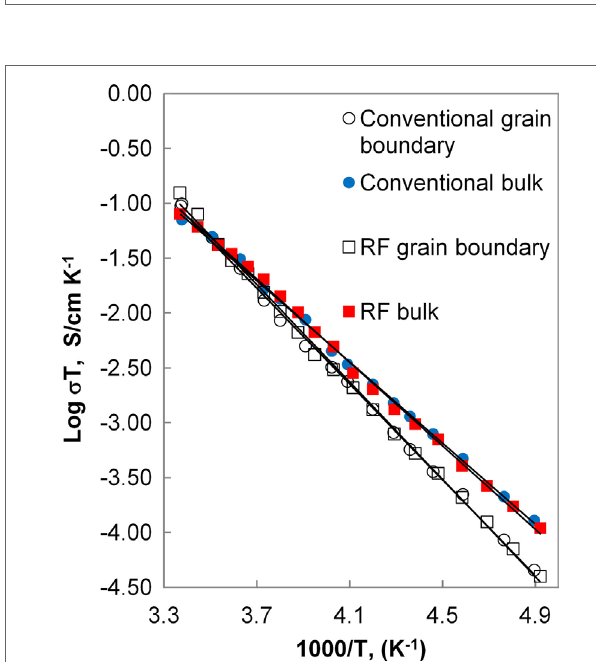
FigUre 10 | Typical nyquist plot of the impedance spectrum for a conventionally sintered sample .